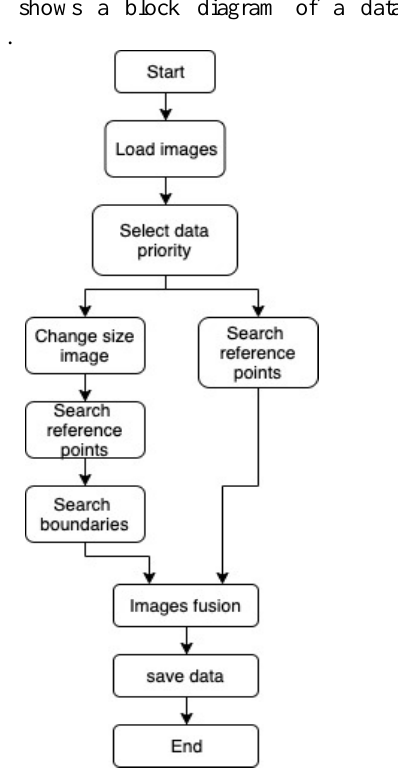
Fig. 1. Block diagram of the algorithm for fusion images obtained in different ranges.